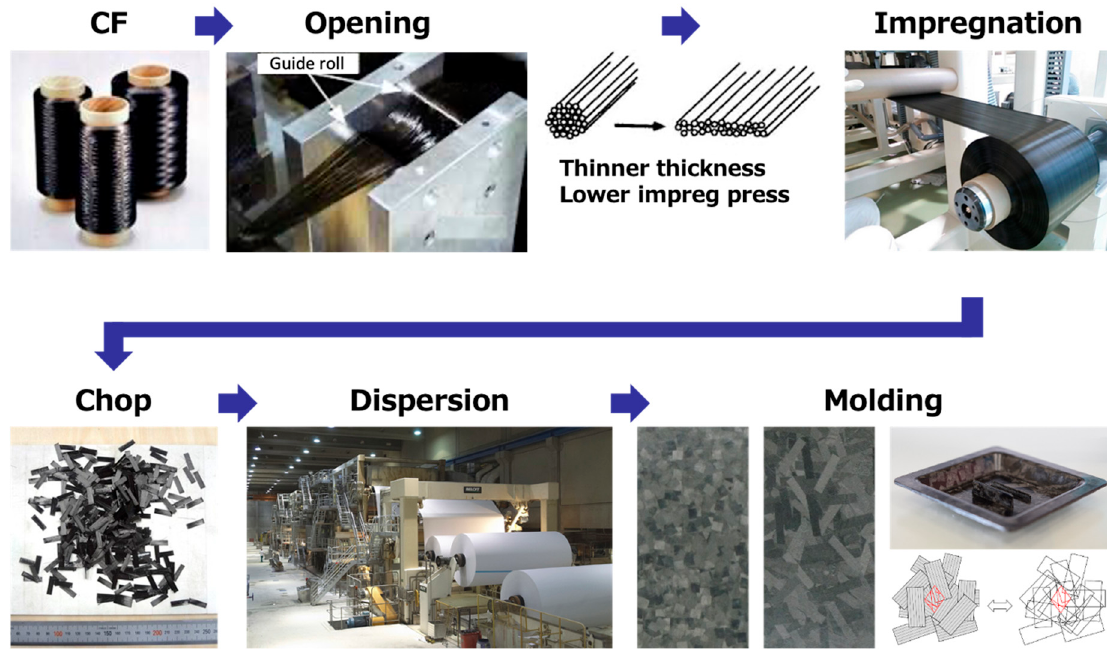
Figure 7. CTT fabrication process.